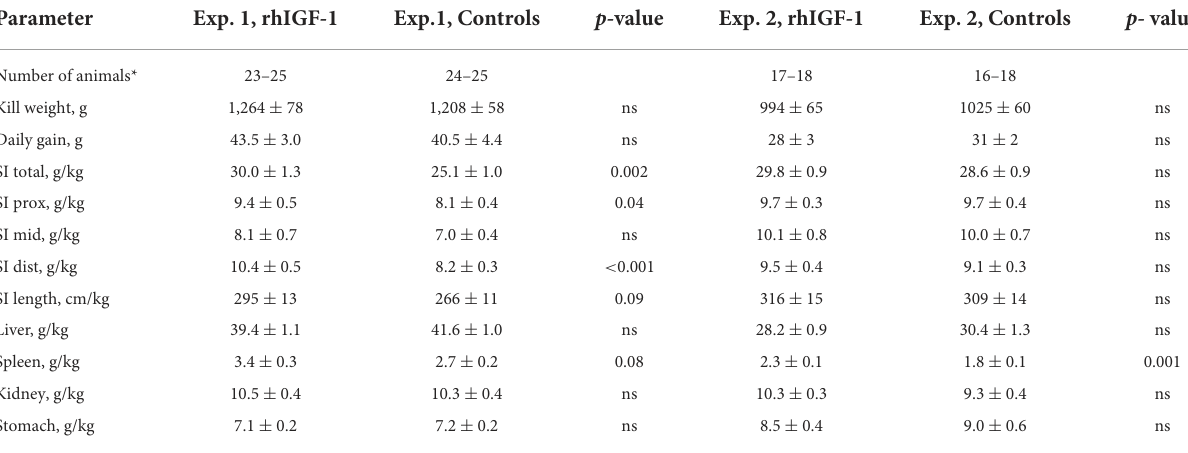
TABLE 1 Body and organ weights of preterm pigs treated with rhIGF-1 or vehicle.